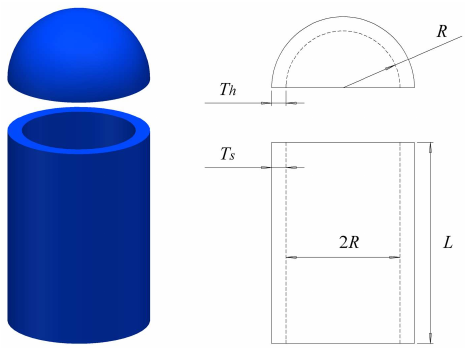
Figure 9. The pressure vessel